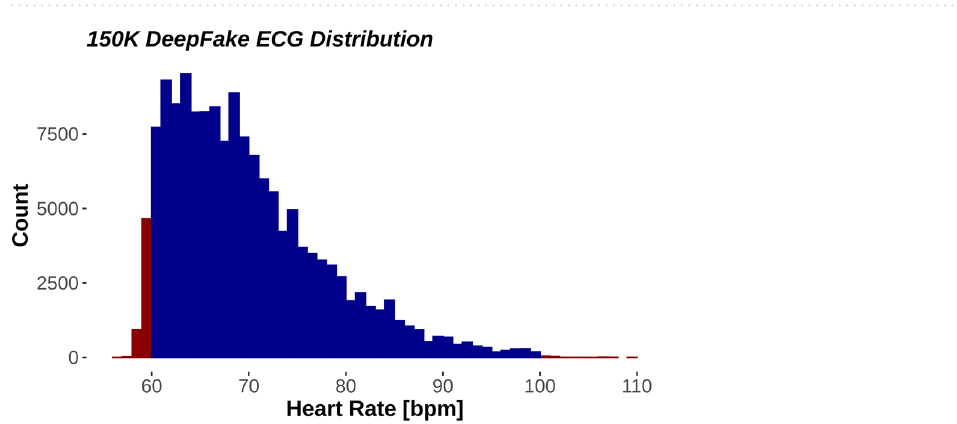
Figure 1. Comparison of examples of a real ECG (left lane) and a DeepFake ECG (right lane). See supplementary Figure S1 for 20 more randomly chosen pairs of real and DeepFake ECGs.